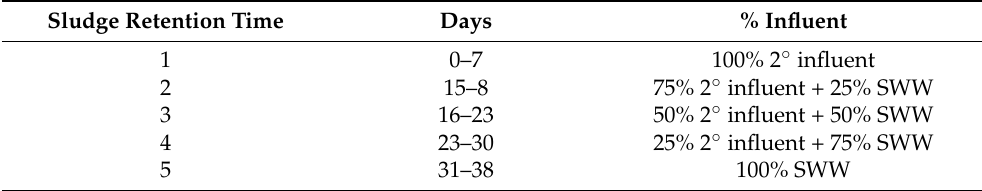
Table 4. Secondary (2 ◦ ) and synthetic wastewater (SWW) influent composition